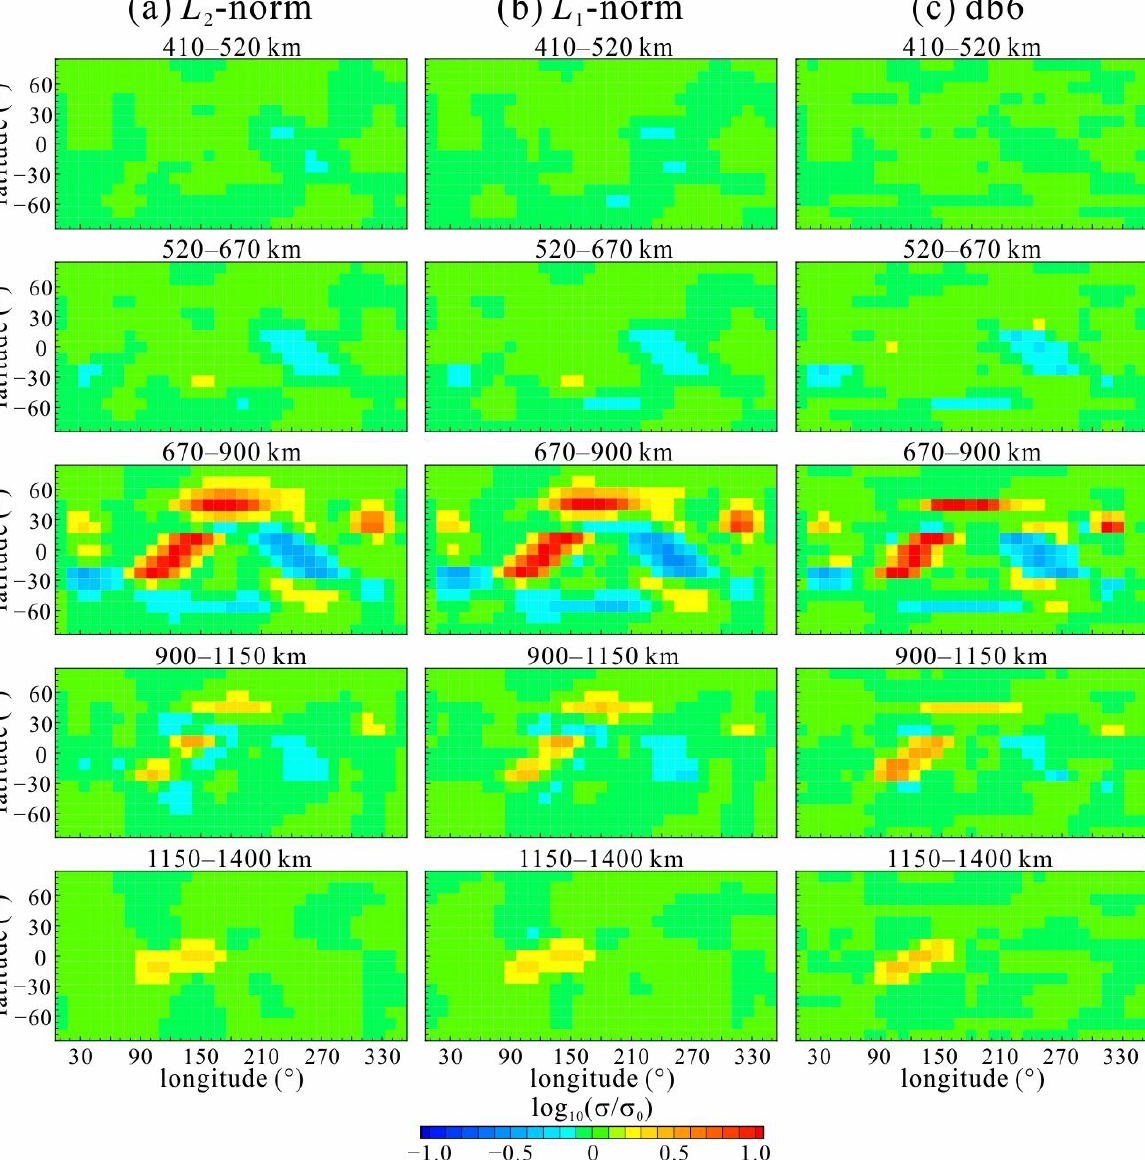
Figure 7. Inversion results of the L p -norm (a: L 2 -norm and b: L 1 -norm) and wavelet-based (c: db6) inversions. The conductivities are allowed to jump at the upper (670 km) and lower (900 km) boundaries of the layer (670 – 900 km) with anomalies in the inversion of L p -norm.